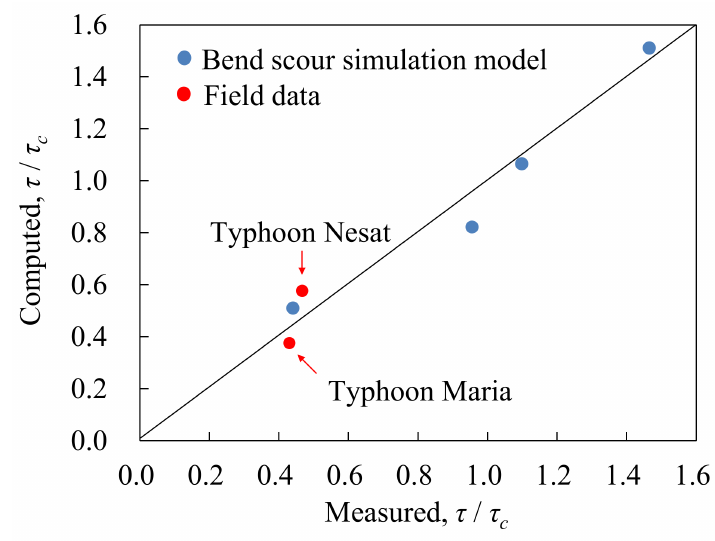
Figure 18. Computed and measured τ / τ c with an R 2 value of 0.95.